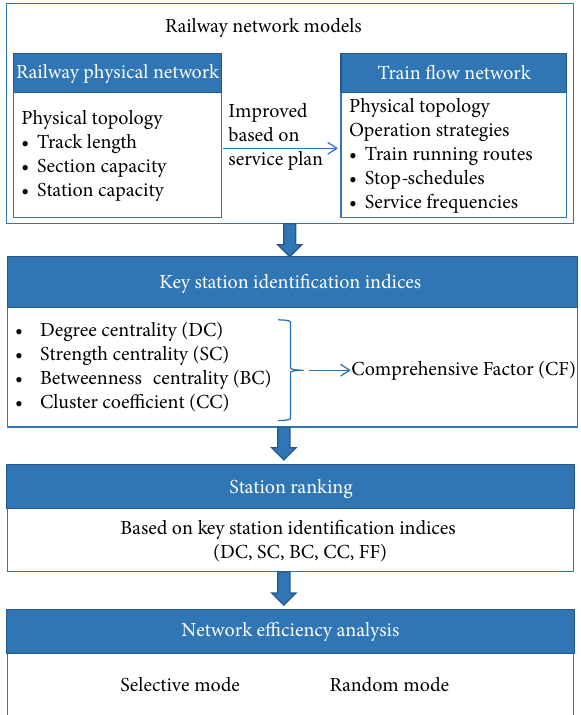
Figure 1: Railway network efficiency analysis process.